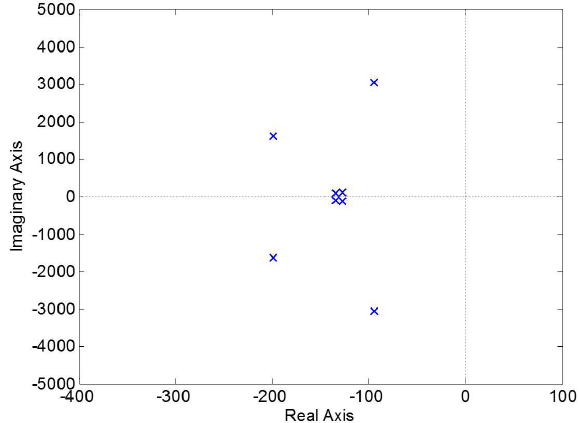
Figure 10. Poles of 1/ ( Y g + Y eq ) for the base case that includes two grid-connected